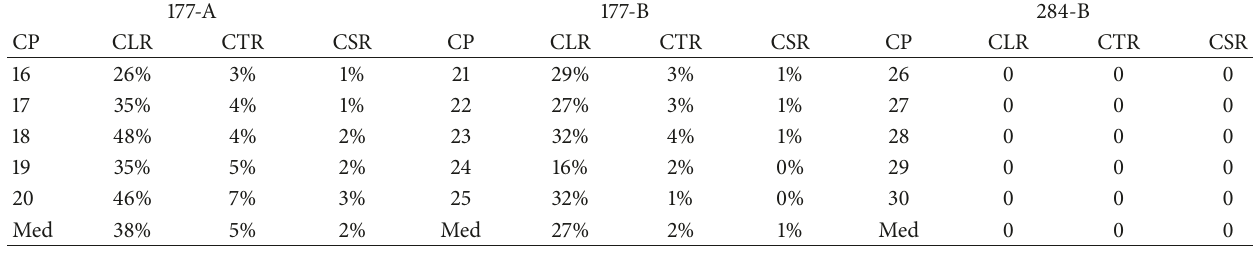
Table 6: HIC test results for the API 5L B steel.